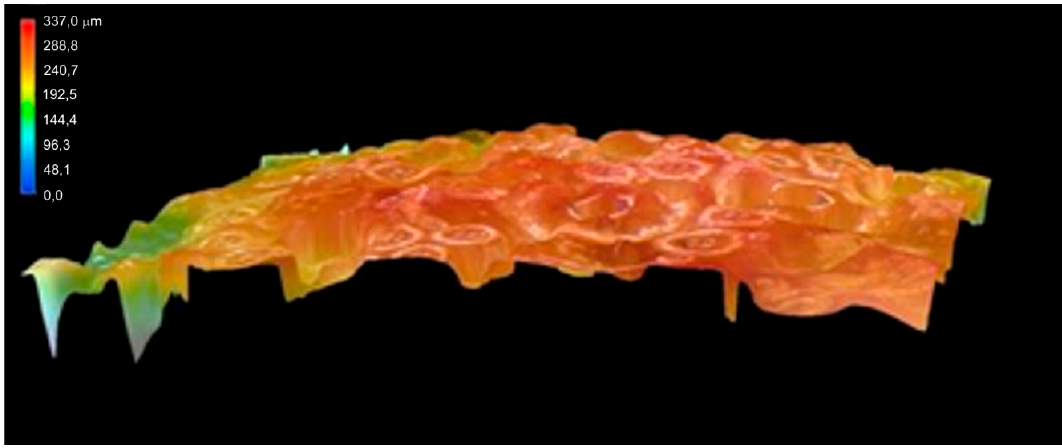
Figure 5. The particles of ground bark scattered in the adhesive mixture.